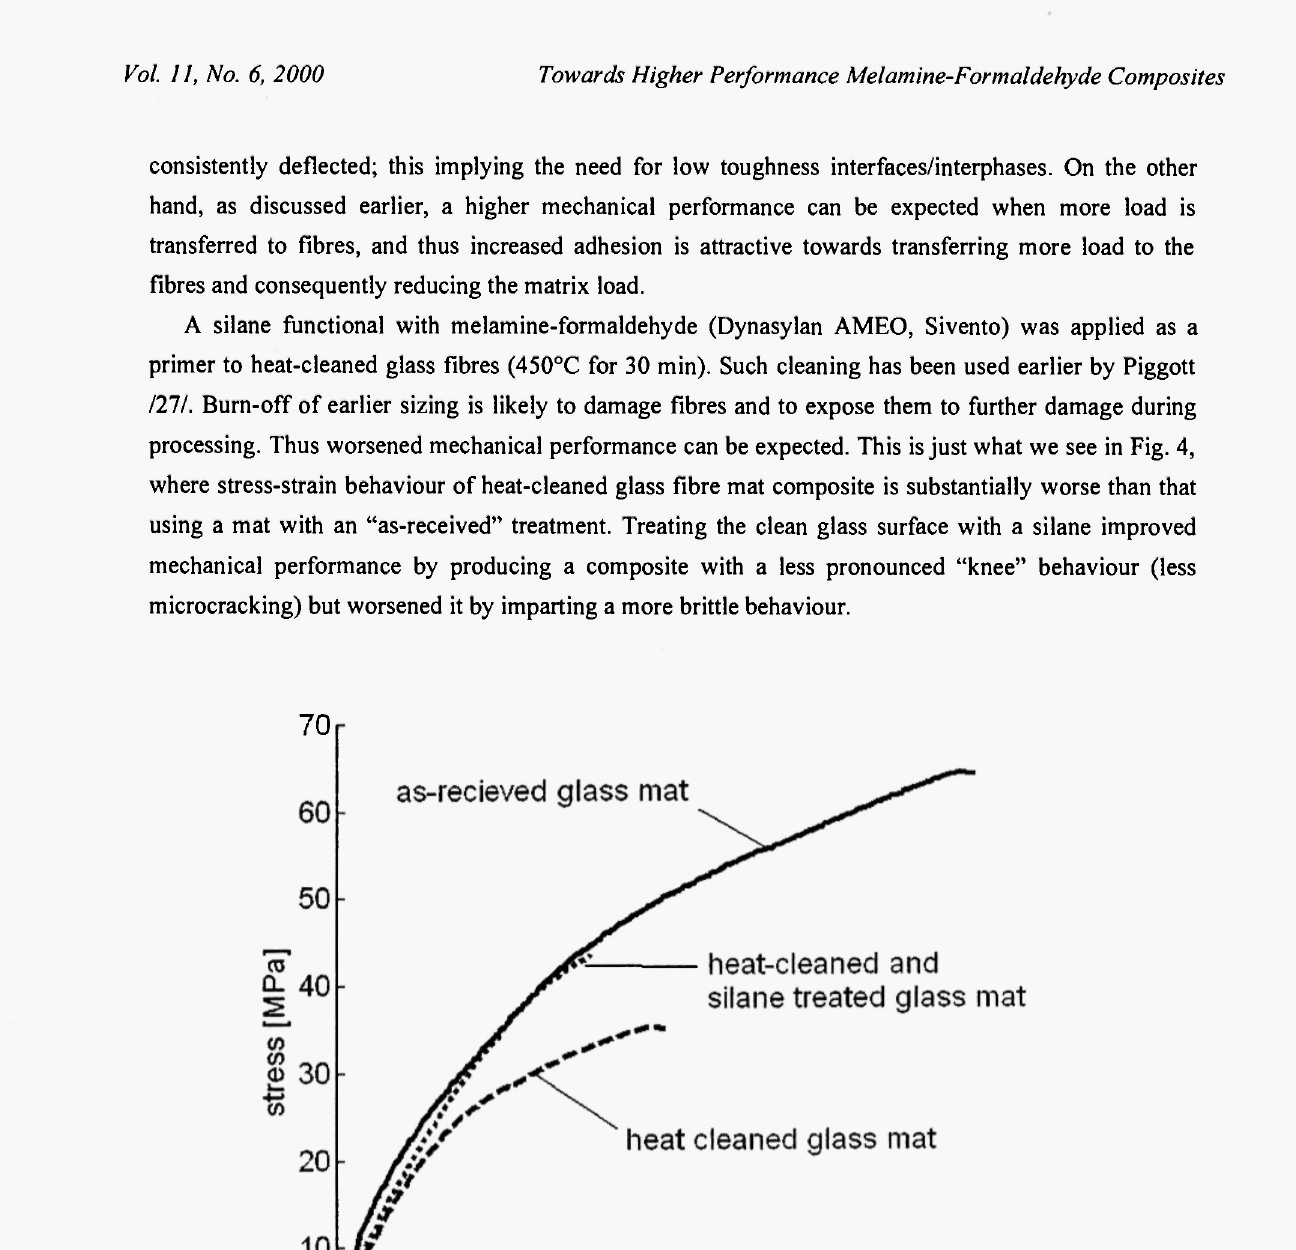
Fig. 4: Stress-strain curves for MF composites made with: as-received, heat-cleaned and heat-cleaned and silane treated glass